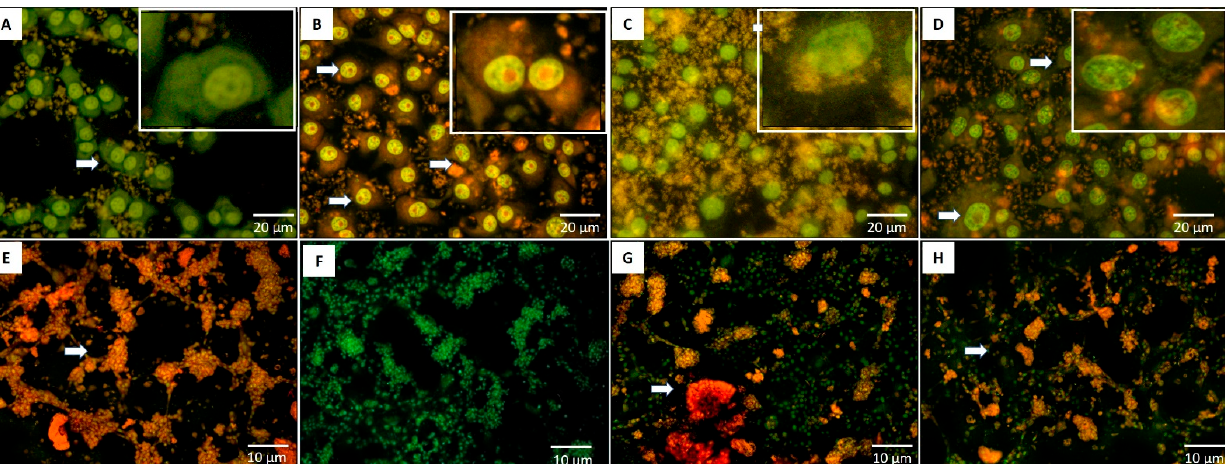
Figure 12. Fluorescence microscopy showing the morphology of A549 cells stained with AO/EB and DAPI after their exposure to ( A , E ) PCIBP, ( B , F ) EPCIBP, ( C , G ) Bev., or ( D , H ) a combination of EPCIBP and Bev. (arrows reveal DNA fragmentation, chromatin condensation, and cytoplasmic degradation; yellow is an early apoptotic stage. Red is a late apoptotic stage).